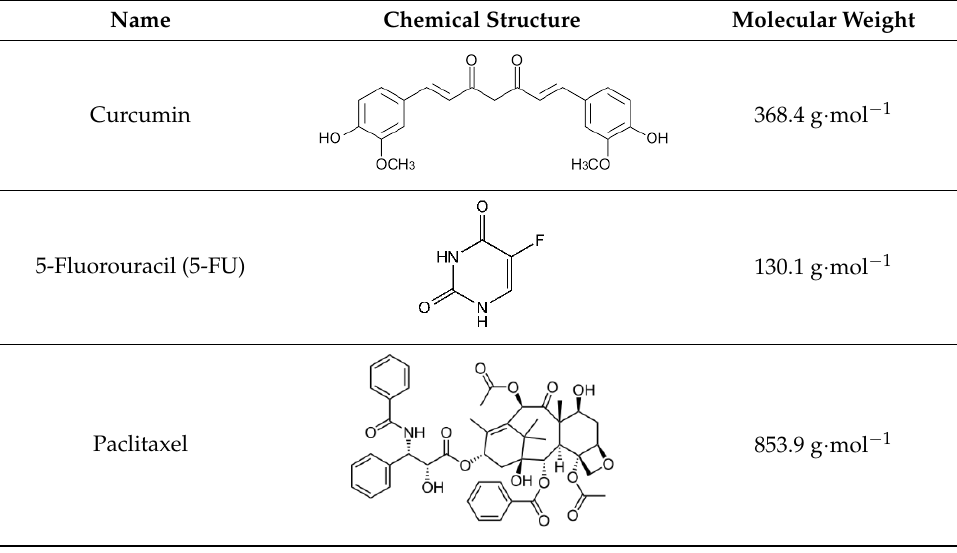
Table 1. List of drugs and model drug used in this study. Name